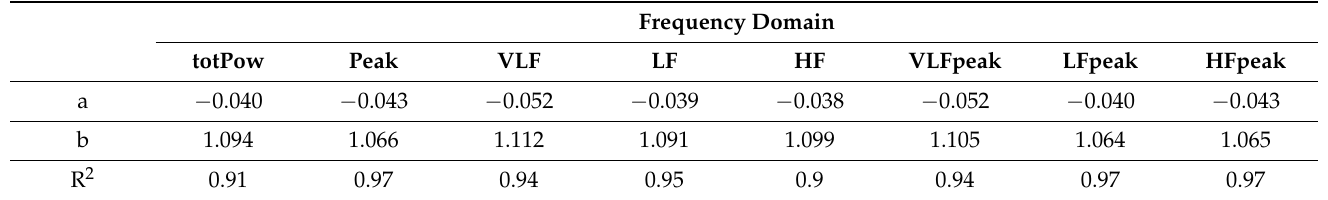
Table A5. Spearman’s Correlation Test—Linear Regressions of the Mean Correlations (subpart 2).